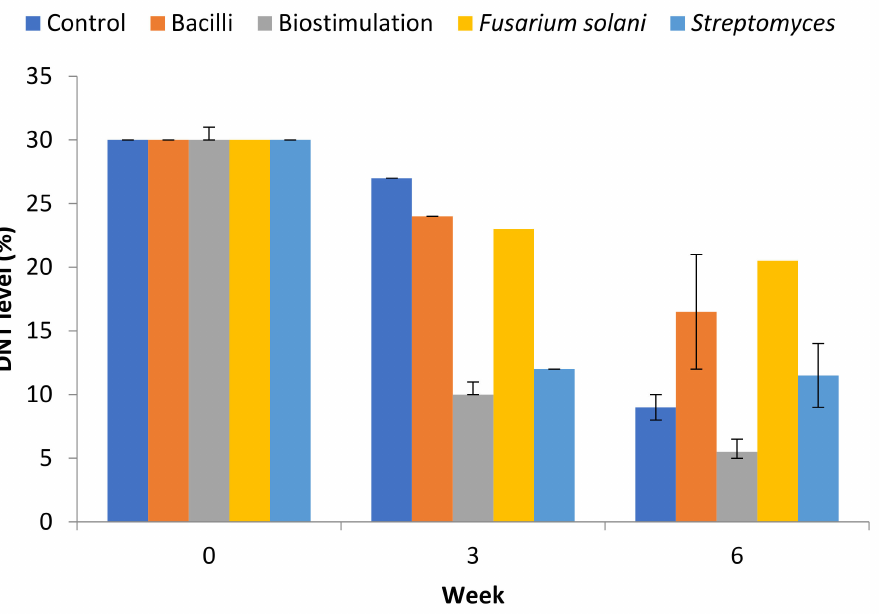
Figure 2. Concentration of DNT over 6 weeks at 20 ◦ C. Results shown represent the mean of duplicates, with standard errors